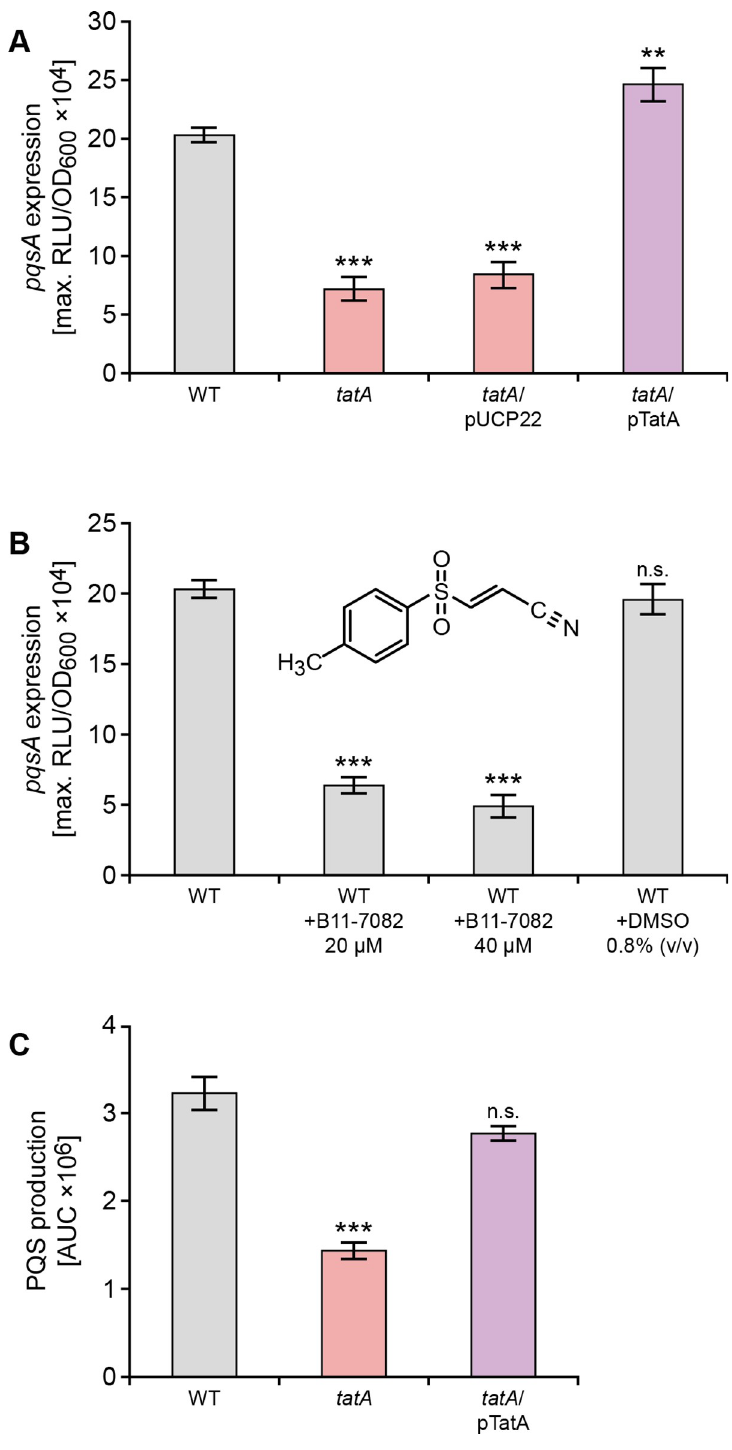
Fig 5. Mutation of tatA or exposure to the Tat inhibitor Bayer 11–7082 inhibits pqsA expression and AQ production. ( A ) Mutation of tatA or ( B ) treatment with Bayer 11–7082 supplied at either 20 μ M or 40 μ M reduces the maximal expression of a P . aeruginosa PAO1 chromosomal pqsA’-lux promoter fusion without affecting growth. ( C ) LC-MS/MS analysis of PQS production by P . aeruginosa PAO1 wild type compared with the tatA mutant and complemented tatA mutant. Experiments were repeated in triplicate at least twice. ��� p < 0.001; n.s. not significant.